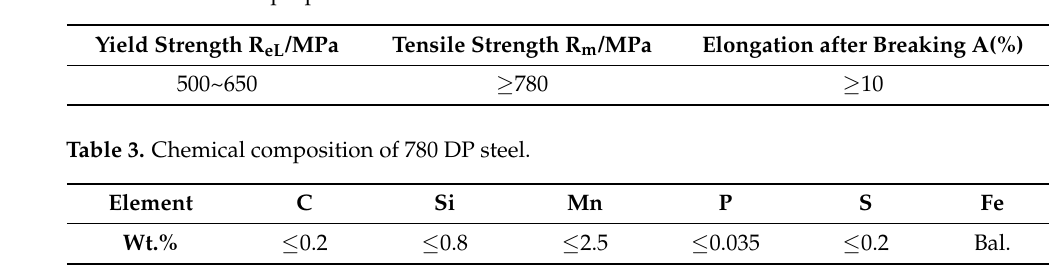
Table 2. Mechanical properties of 780 DP steel.